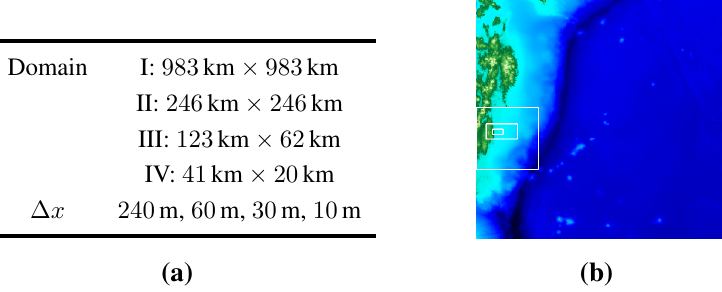
Figure 9. Tohoku tsunami. ( a ) Parameters; ( b ) bathymetry.